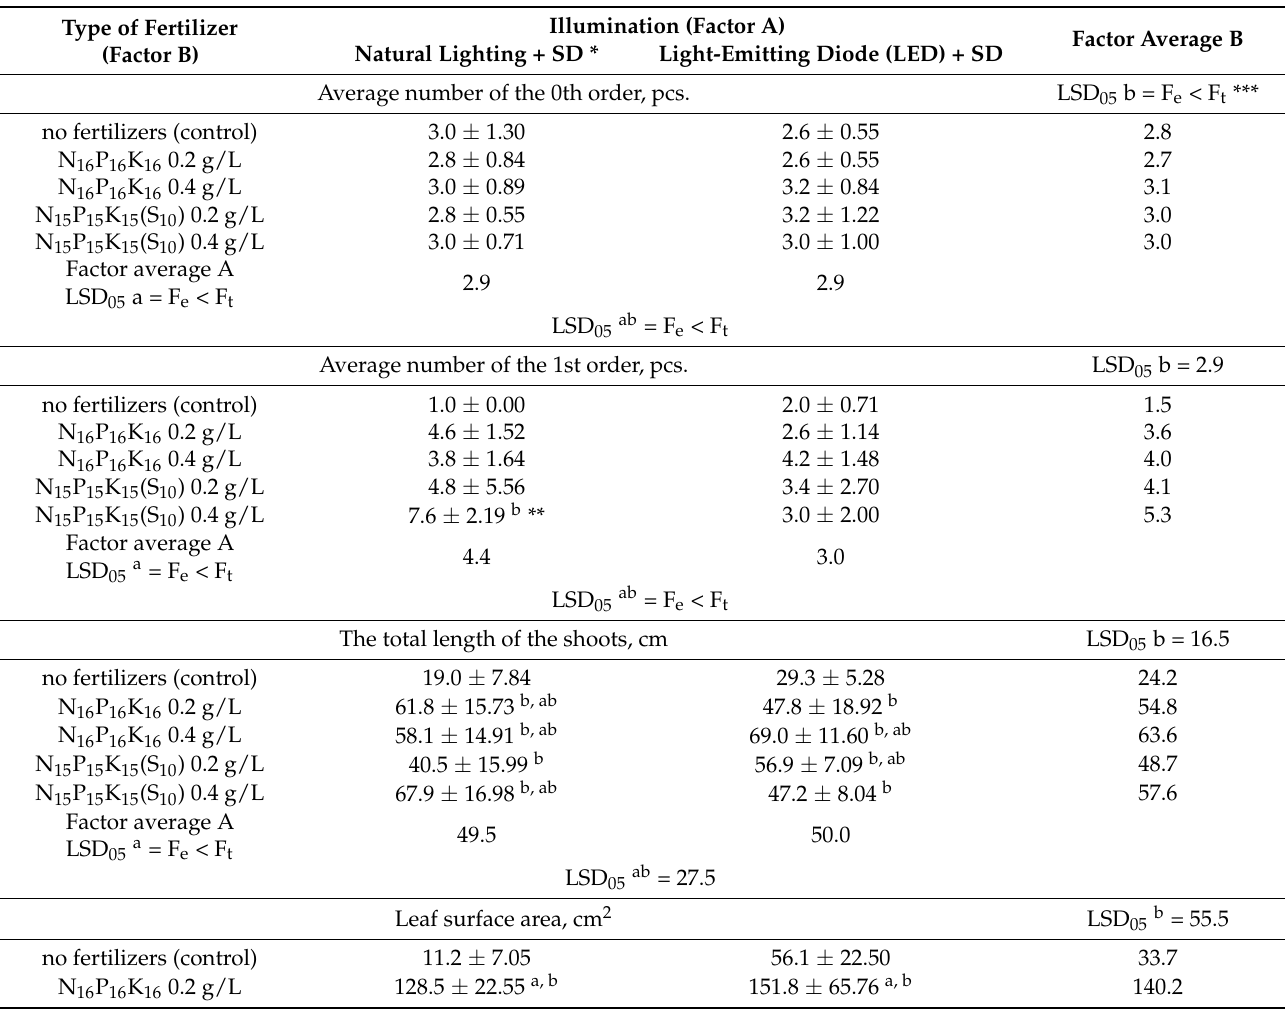
Table 4. Morphometric indicators of ex vitro development in highbush blueberry ( Vaccinium corymbo- sum L.) plants cv. Brigitta Blue on the 56th day of growing